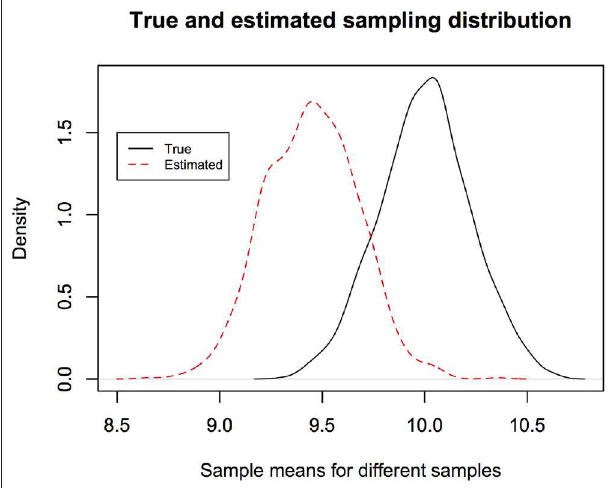
FIGURE 1 | The estimated sampling distribution depends on the observed data and is different from the true sampling distribution. Hence the parameter estimate of a new study may lie outside the confidence interval reported in an earlier study more often than the nominal error rate. The new estimate is occurring from the true sampling distribution and the previous confidence interval is based on the estimated sampling distribution. It is approximately the area outside the reported confidence interval under the true sampling